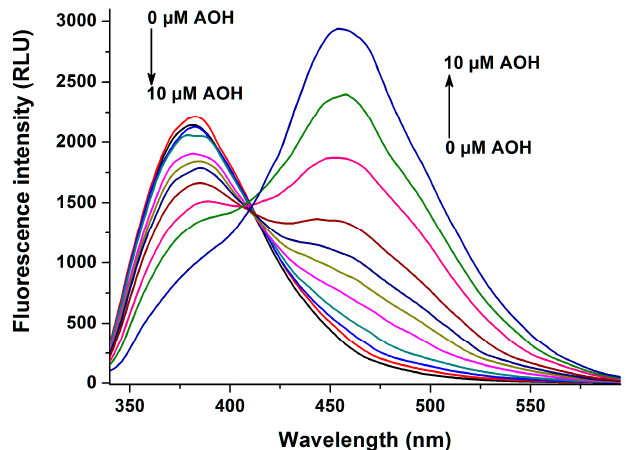
Figure 8. Fluorescence emission spectrum of warfarin (1.0 μ M) in the presence of HSA (3.5 μ M) and increasing concentrations of AOH (0.0, 0.1, 0.25, 0.5, 1.0, 1.5, 2.0, 3.0, 5.0, 7.0, and 10.0 μ M) in PBS (pH 7.4; λ ex = 317 nm).